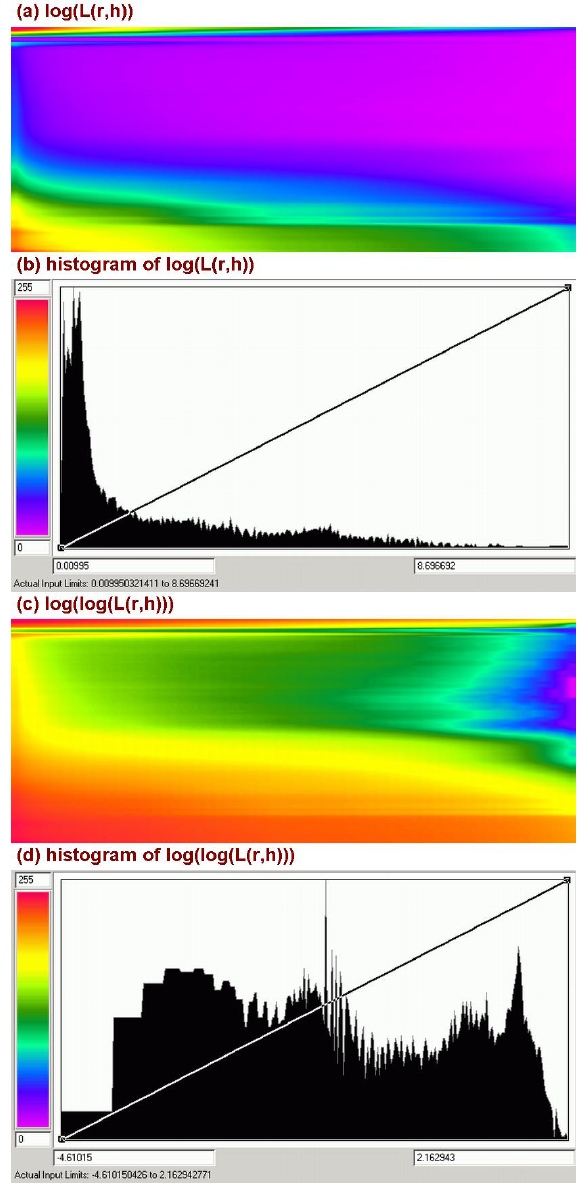
Figure 4. (a) Colour coded visualization of log( L ( r , h )) at a certain ( x , y ); (b) The histogram and transfer function of image in (a); (c) Colour coded visualization of log(log( L ( r , h ))) of the same data L ( r , h ); (d) The histogram and transfer function of image in